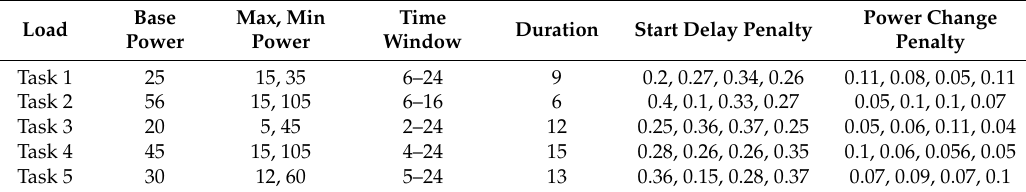
Table 4. Parameters of schedulable loads.